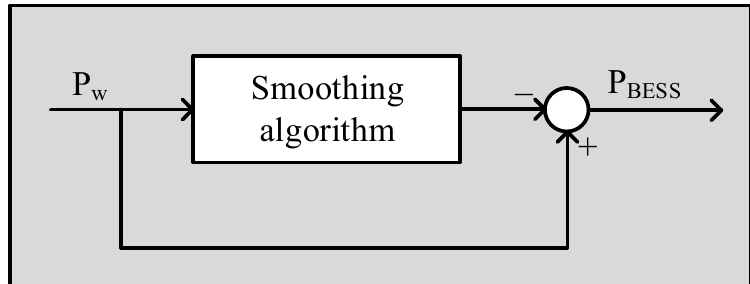
Figure 3. Battery Reference signal generation procedure.